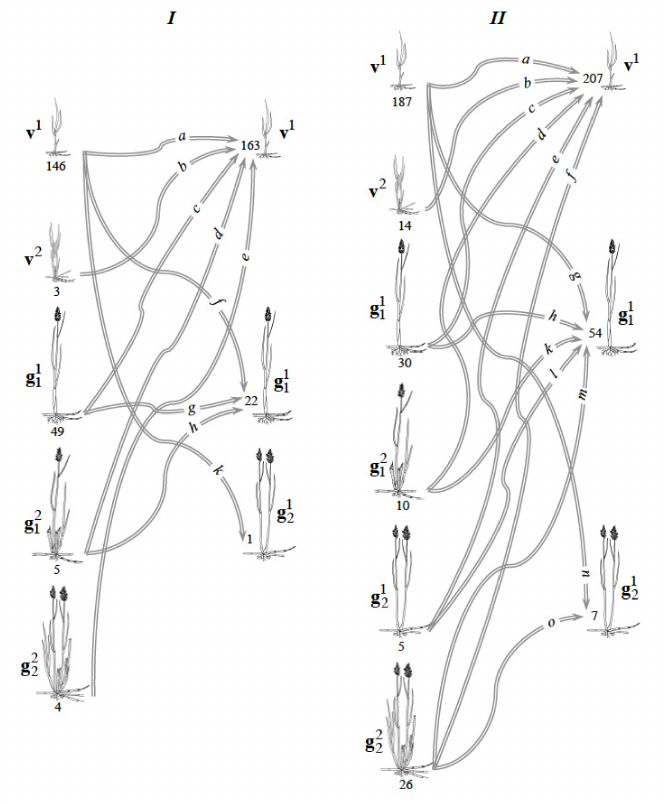
Figure 3. Survival diagram for young rhizomes of the parental plants at different age–stage statuses according to the excavation data of two Calamagrostis epigeios colonies ( I and II ). The number below the image of a parent plant at a particular status equals the total number of young rhizomes among the parents of this status; the number near the young descendant image equals the total number of recruits at the corresponding status. Parameters a, b , . . . , n , o denote the number of alive descendants of the parents at the corresponding status